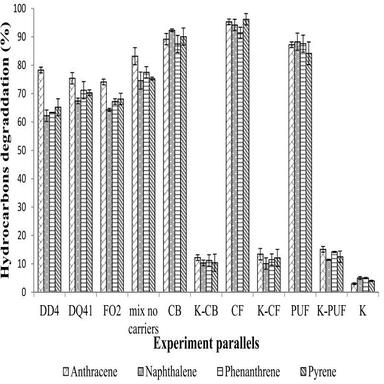
PAH degradation by different types of biofilms. DD4, DQ41, FO2: biofilm formed by each PPB strains; Mix no carriers: biofilm formed by mixture of the PPB strains without carriers; CB: biofilm formed by the PPBs on CB; K-CB: abiotic control of CB; CF: biofilm formed by the PPBs on CF; K-CF: abiotic control of CF; PUF: biofilm formed by the PPBs on PUF; K-PUF: abiotic control of PUF; K: control without carriers nor bacteria. Error bar represents the standard deviation (n ¼ 3).